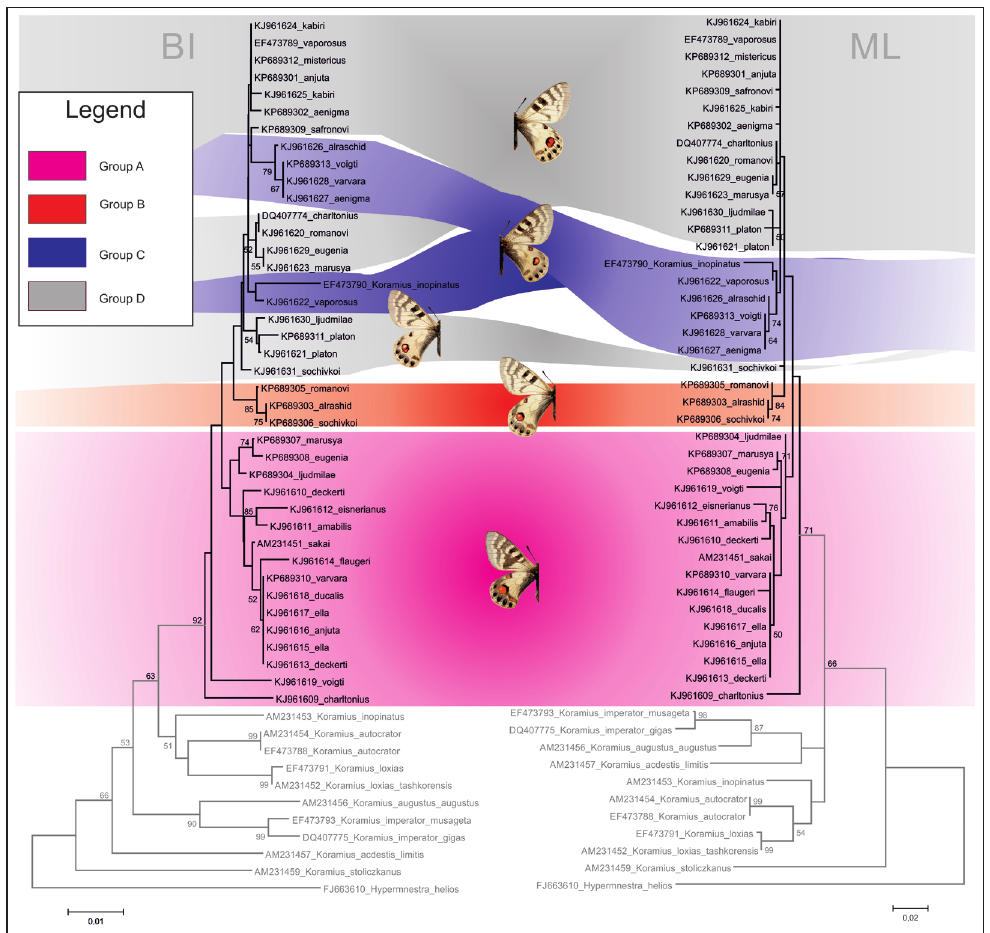
Figure 7. The Bayesian inference (BI) and maximum likelihood (ML) trees of Koramius charltonius and closely related taxa. Outgroups are shown in grey. The colours represent the four haplotype lineages.